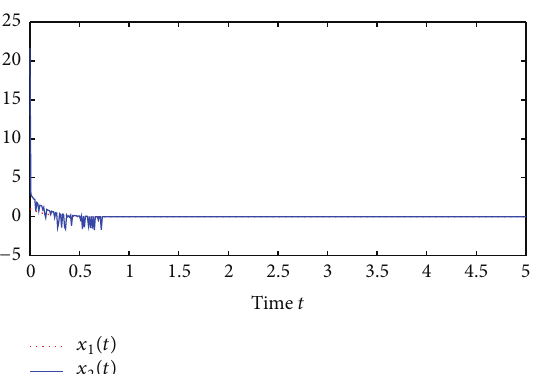
Figure 3: Controller output.